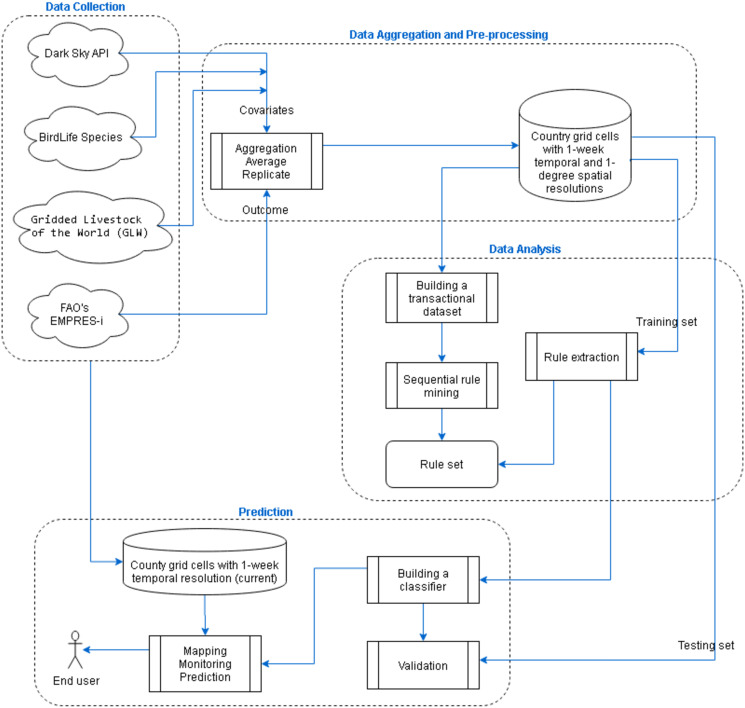
Overall framework.